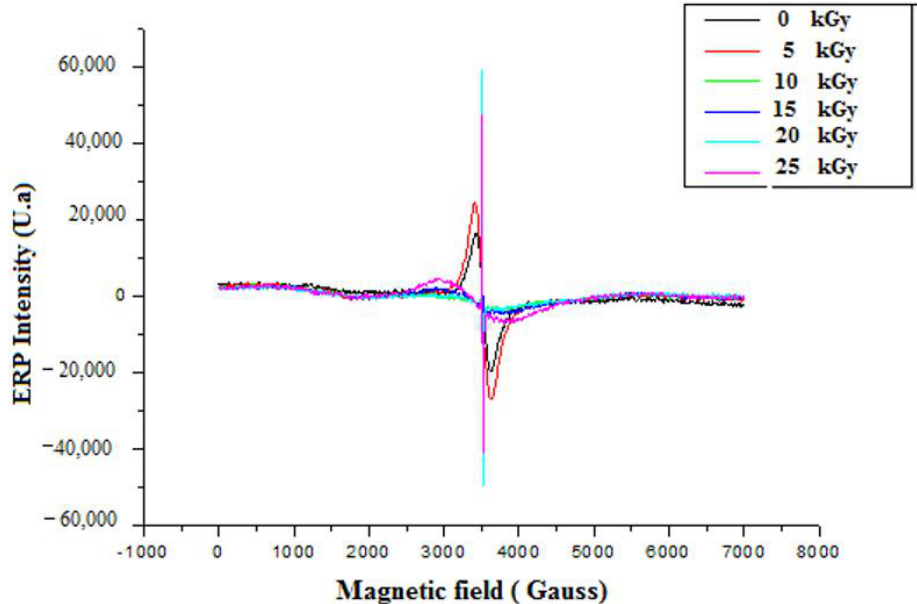
Figure 6. EPR spectrum of irradiated gelatine–chitosan–Pomegranate peel (GEL–CH–PP) composite with different γ -radiation doses, 5, 10, 15, 20, and 25 kGy, in comparison with control samples (0 kGy).